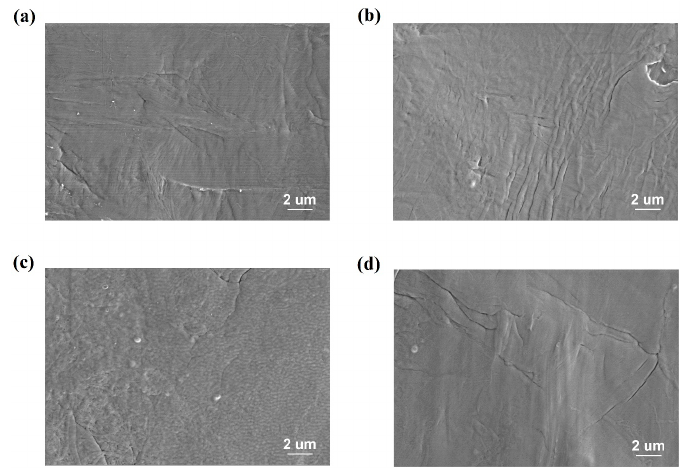
Figure 3. The surface SEM images of ( a ) P(VDF-CTFE). ( b ) The film treated at 8 kV for 60 s. ( c ) The film treated at 10 kV for 15 s. ( d ) The film treated at 10 kV for 60 s.